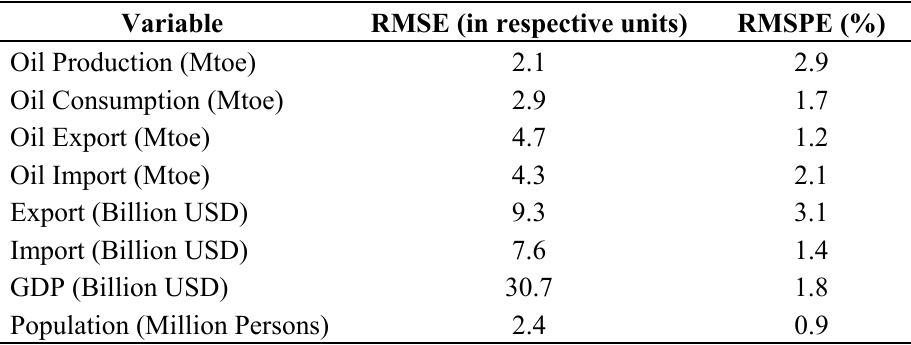
Table 4. Behavior test results of critical